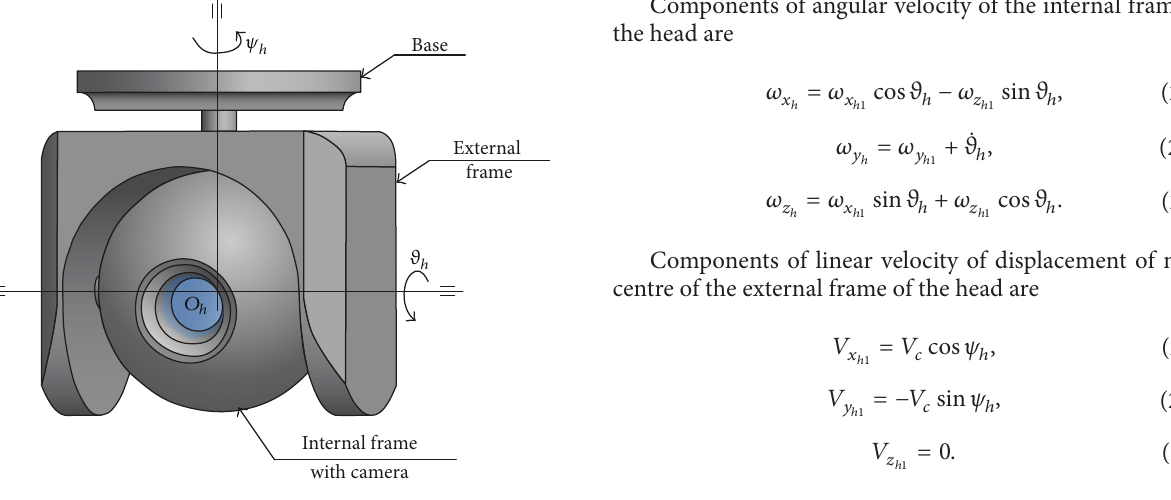
Figure 4: General view of the observation and tracking head.